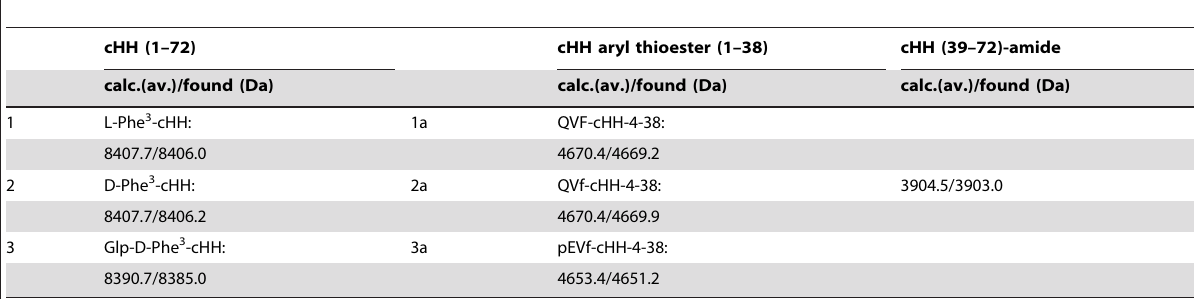
Table 1. ESI-MS data of cHH analogues ( 1 – 3 ), thioesters ( 1a – 3a ) and cHH (39–72)-amide.